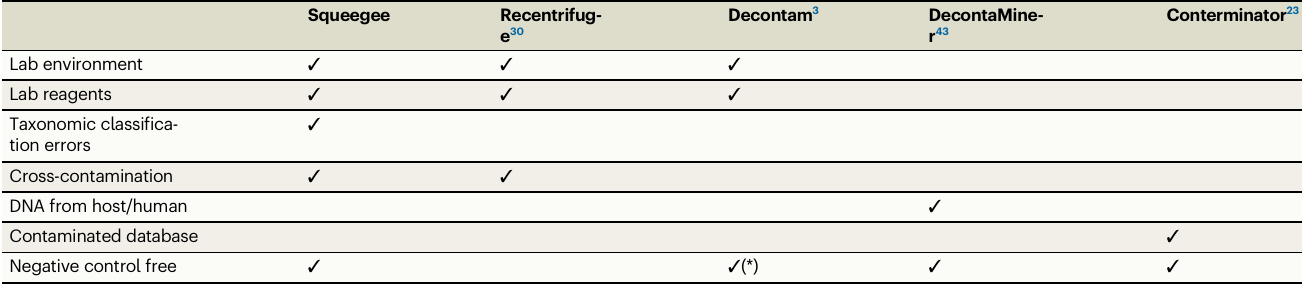
Table 2 | Tools comparison on handling contamination from a different